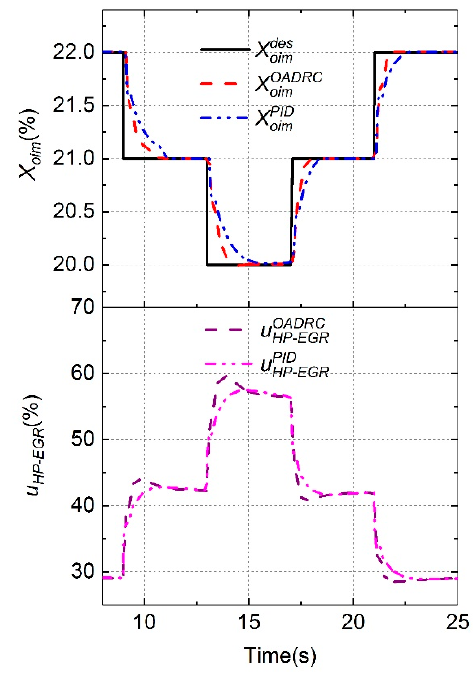
Figure 14. Comparison between OADRC and PID controller with step changes of intake oxygen concentration. Table 7. Comparison between OADRC and proportional-integral-differential (PID) controller with step changes of intake oxygen concentration.